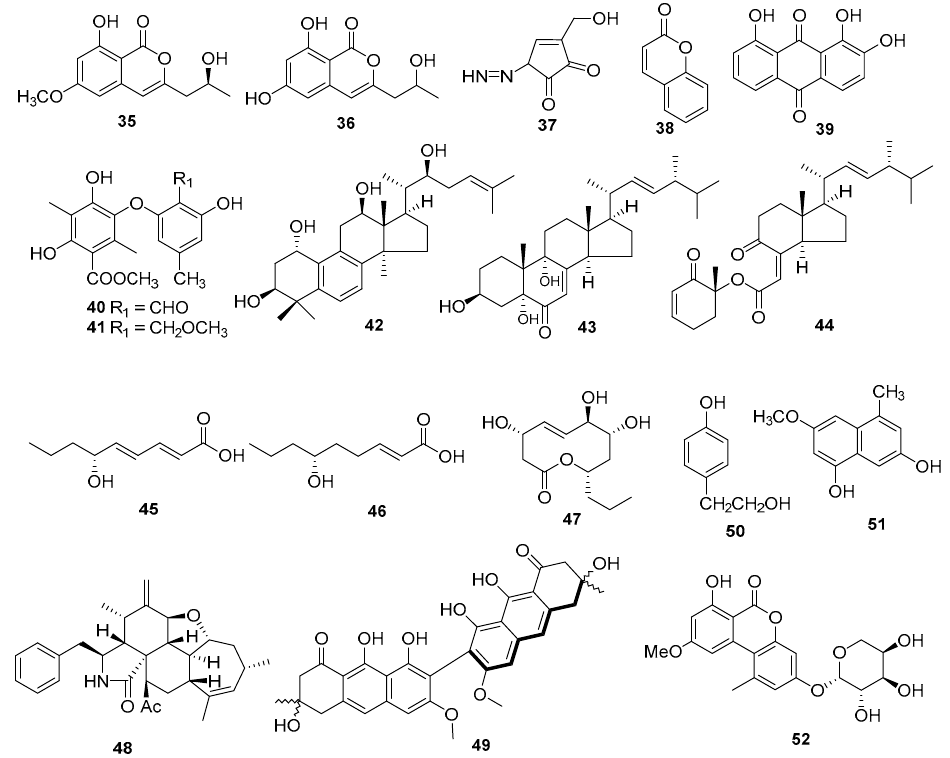
Figure 2. Chemical structures of compounds 35 – 52 of terrestrial origin.